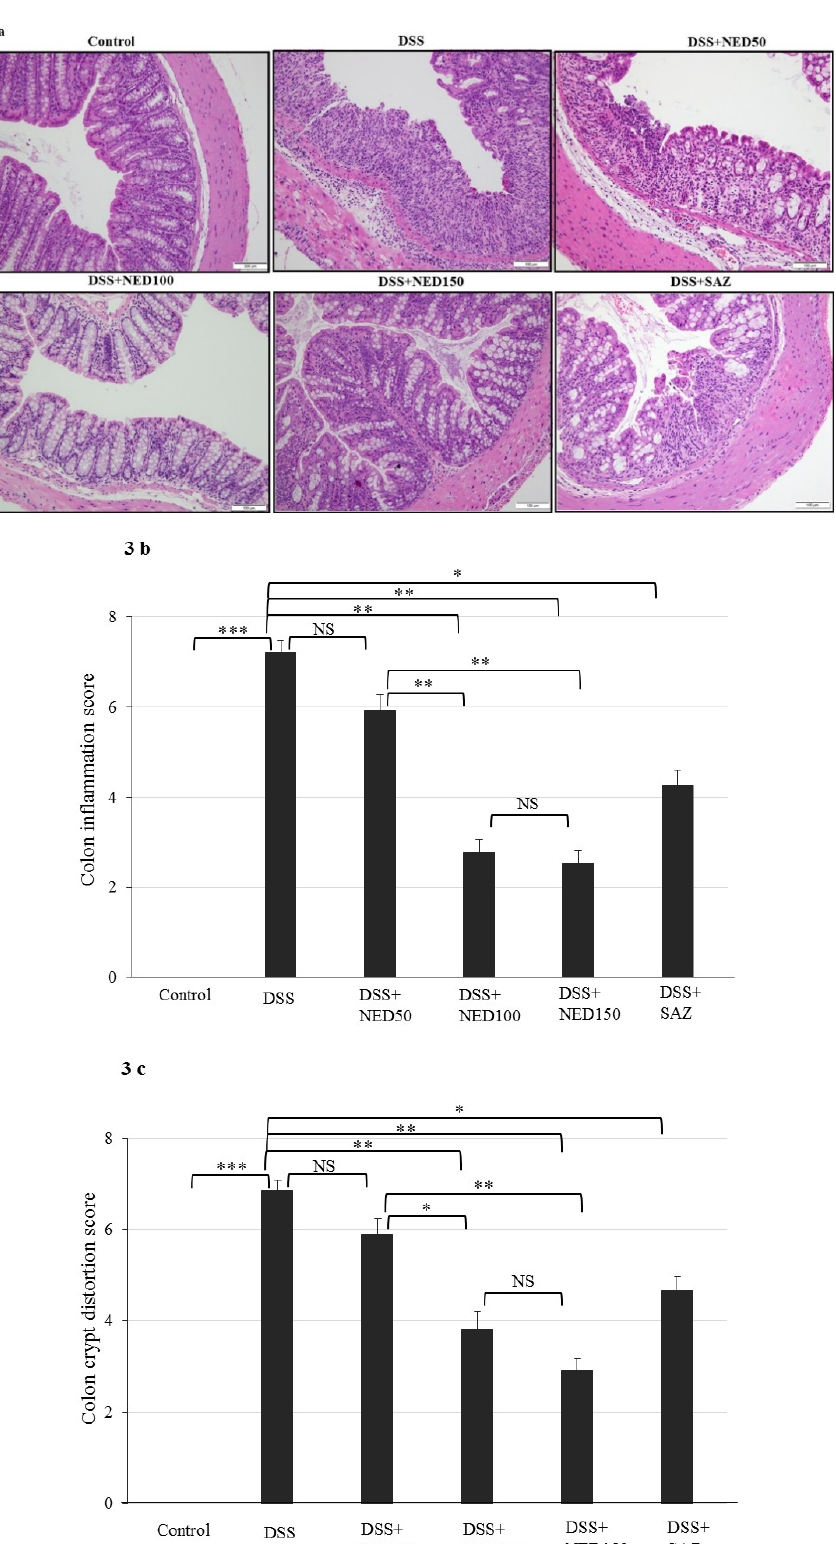
Figure 3. E ff ect of NED on colon histology. ( a ) Microscopic analysis shows typical architecture of the colon with normal thickness of the submucosa, muscle layer and regular crypt and villi structure in the mucosa in the control samples (Scale Bars: 100 µ M). The DSS-induced colitis colon section shows focal loss of crypts and surface epithelium with inflammation reaching up to the submucosa.